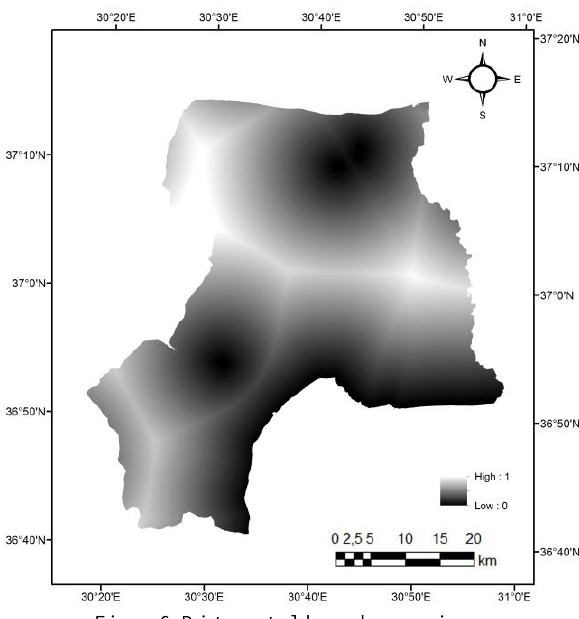
Figure 6. Distance to lake and reservoir area